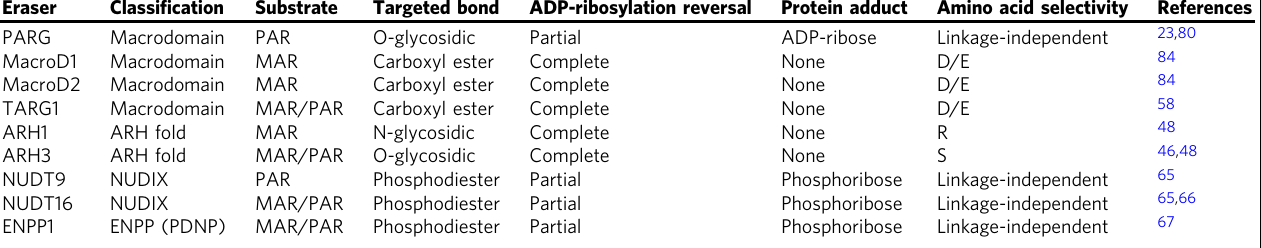
Table 1 Human ADP-ribose erasers